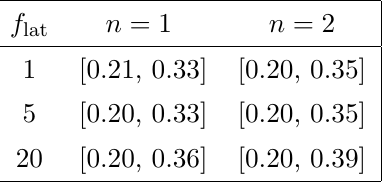
as a function of the truncation power n of J/ψ